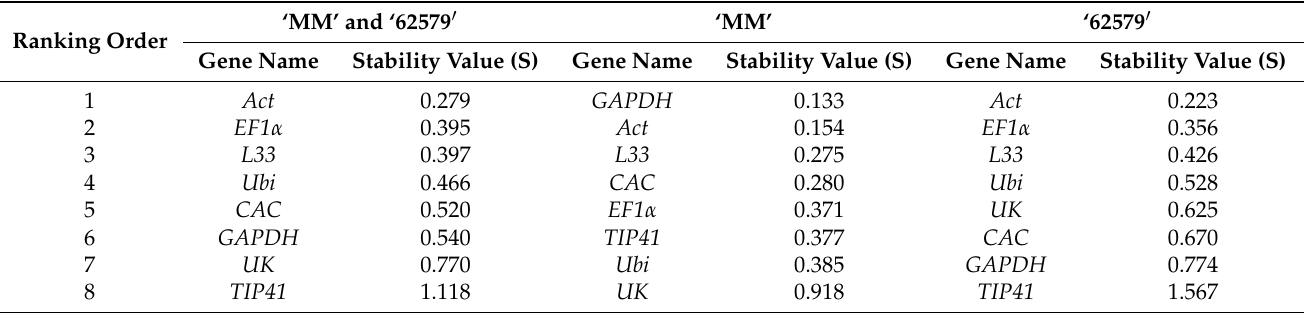
Table 2. Analysis results of NormFinder Software.